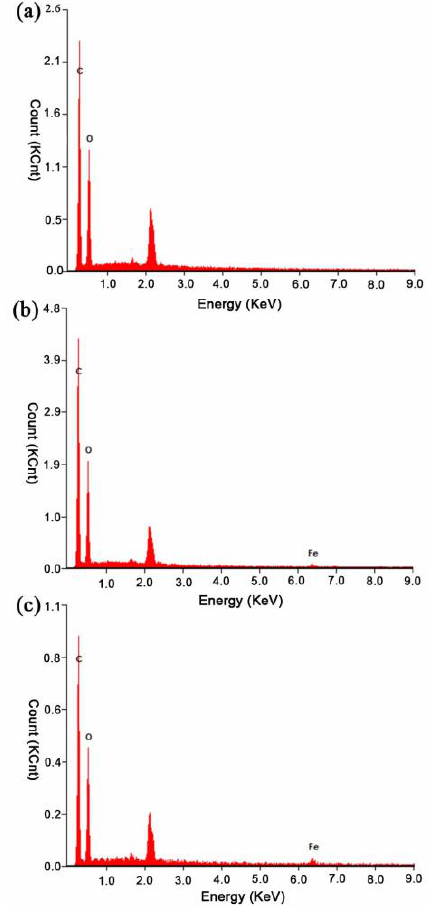
Figure 3. Energy dispersive X-ray spectroscopy results for surface compositions of: ( a ) neat PLLA nanofibers; ( b ) 2% Fe 3 O 4 /PLLA nanofibers; and ( c ) 5% Fe 3 O 4 /PLLA nanofibers. The y -axis shows the count number of X-rays received by the detector (with a unit of 1000 count, KCnt) and the x -axis shows the energy level of the peaks (with a unit of kiloelectron volts, KeV).